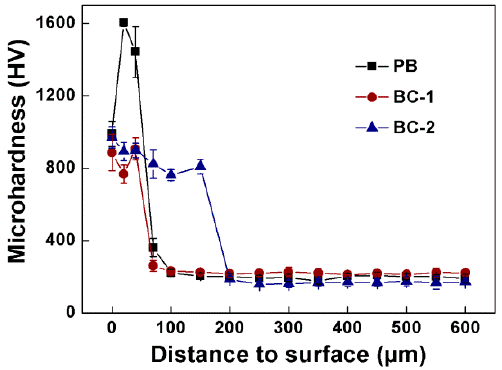
Figure 7. Microhardness plotted as a function of distance to the coating surface of various samples.